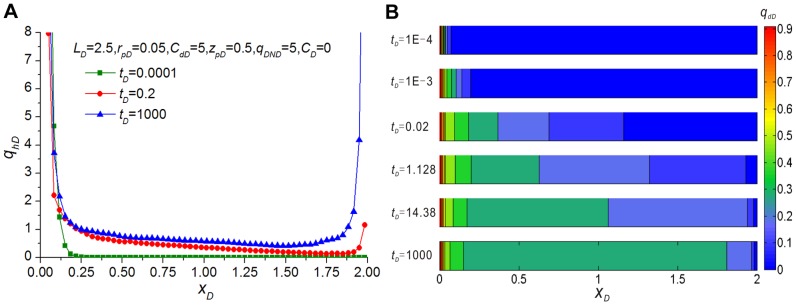
Dimensionless influx rate distribution at tD  = 0.0001, 0.2 and 1000 (A) and dimensionless flow rate distribution at tD  = 10−4, 10−3, 0.02, 1.128, 14.38 and 1000 (B) along the preferential flow path (LD  = 2.5, rpD  = 0.05, CdD  = 5, zpD  = 0.5, qDND  = 5, CD  = 0).